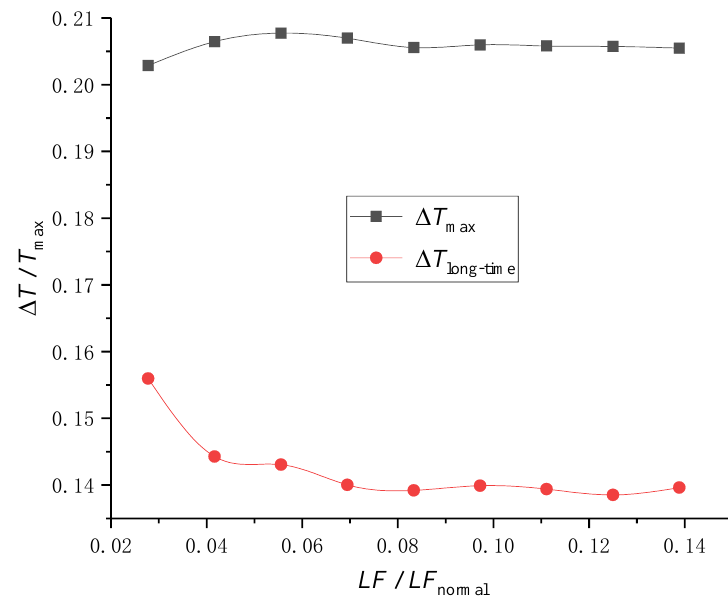
Figure 11. The temperature difference in different water leakage flow ( LF ).